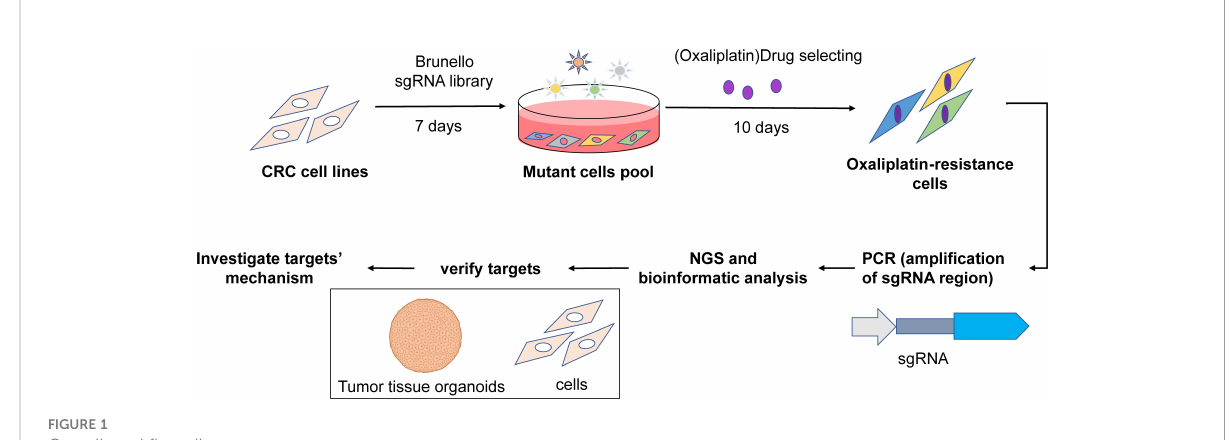
FIGURE 1 Overall work fl ow